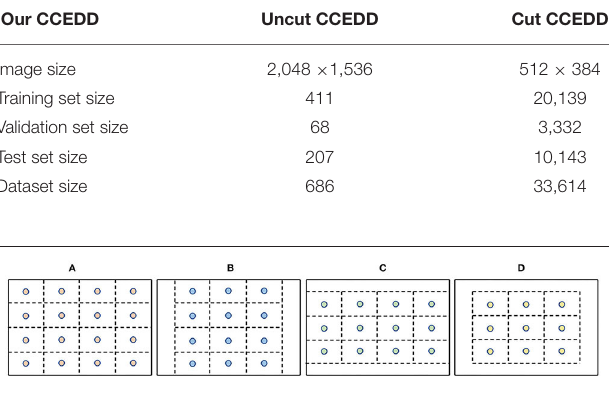
4 cutting grid; (B) move the grid ×